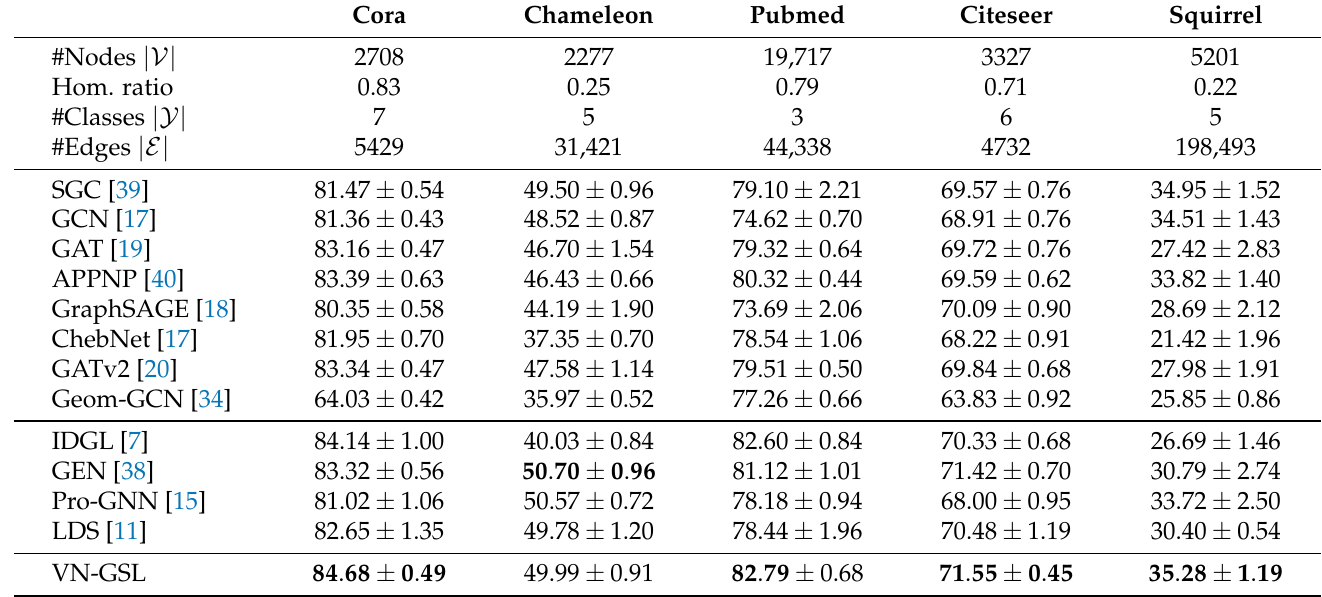
Table 2. Performance comparison of graph neural network models on multiple datasets (mean accuracy ( % ) ± stdev).